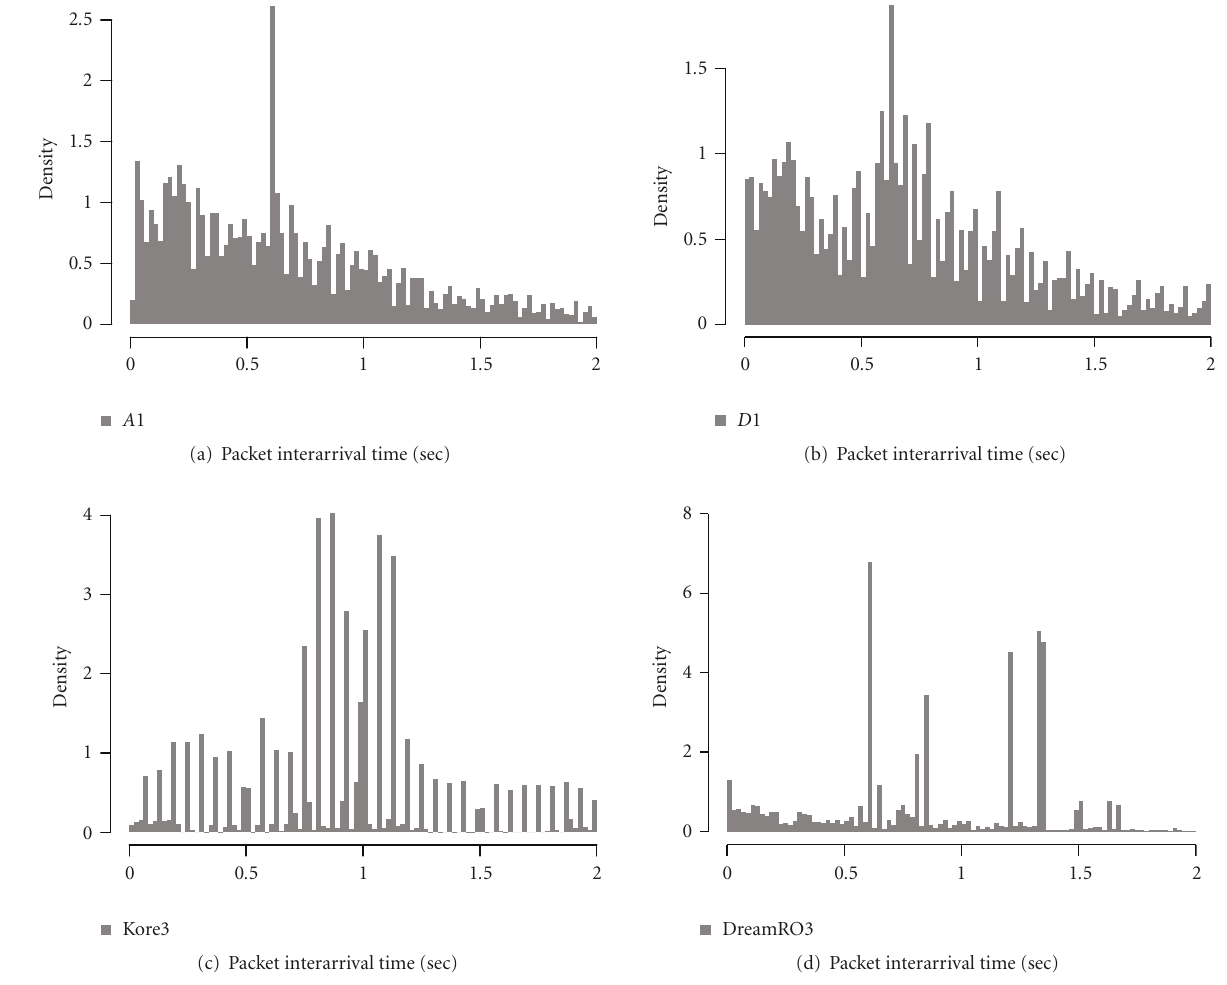
Figure 1: Histogram of packet interarrival